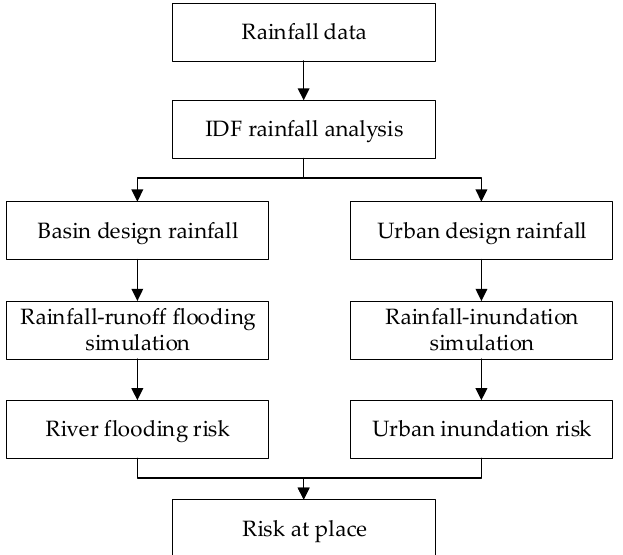
Figure 1. Conventional design rainfall-based flood and inundation risk assessment procedure.